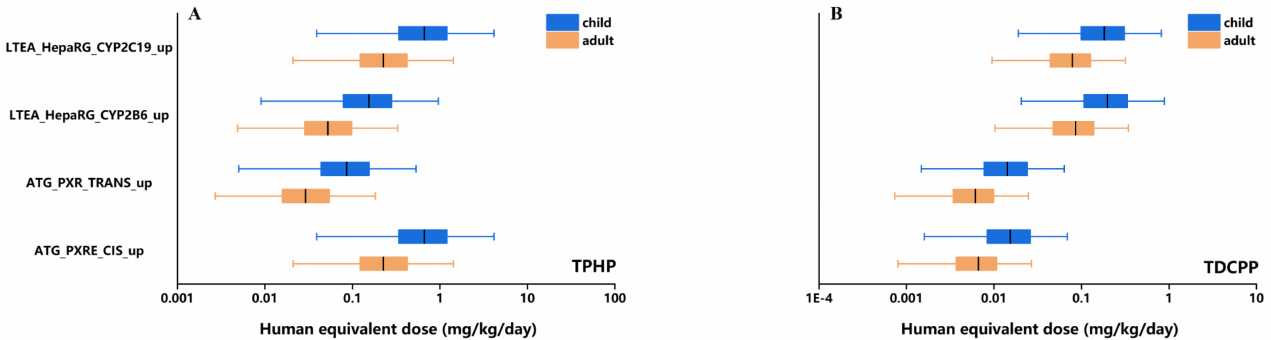
Figure 3. HEDs of TPHP ( A ) and TDCPP ( B ) derived from in vitro hepatocyte assays. Different percentiles of HED for each population were calculated (P2.5, P25, P50, P75 and P97.5).